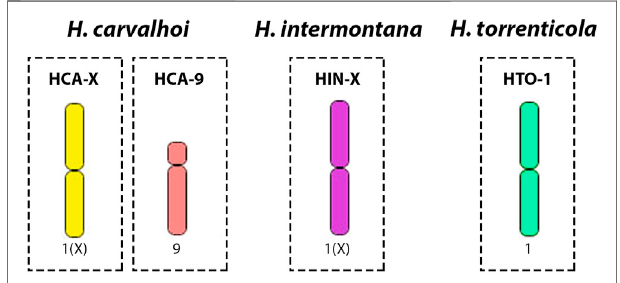
FIGURE 1 | Schematic representation of the microdissected chromosomes used for probe construction in comparative WCP-FISH analyses. 1) the X chromosome of H. carvalhoi (HCA-X, in yellow); 2) chromosome 9 of H. carvalhoi (HCA-9, in light pink); 3) the X chromosome of H. intermontana (HIN-X, in purple); 4) chromosome 1 of H. torrenticola (HTO-1, in